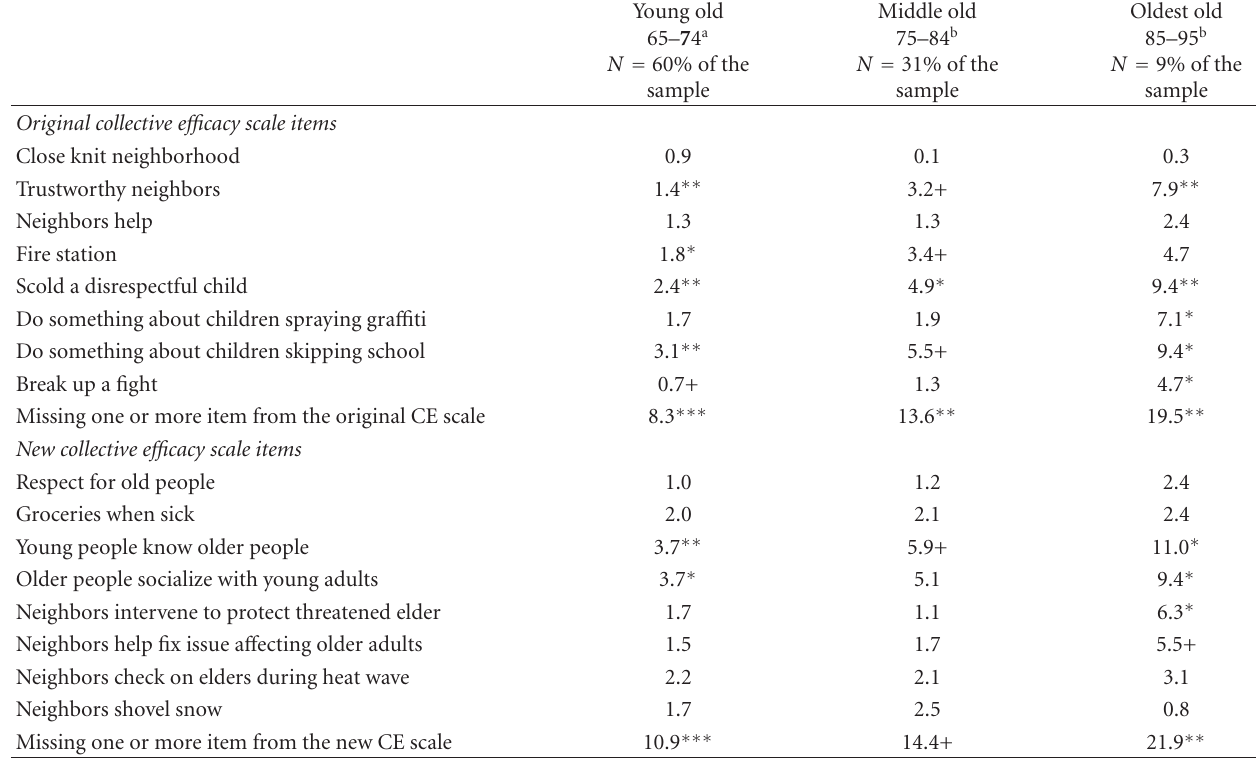
Table 2: Percent missing each collective e ffi cacy xcale item, by age